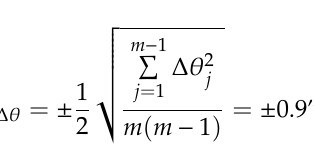
Figure 8. Angular positioning deviation of the rotary table at each indexing angle.